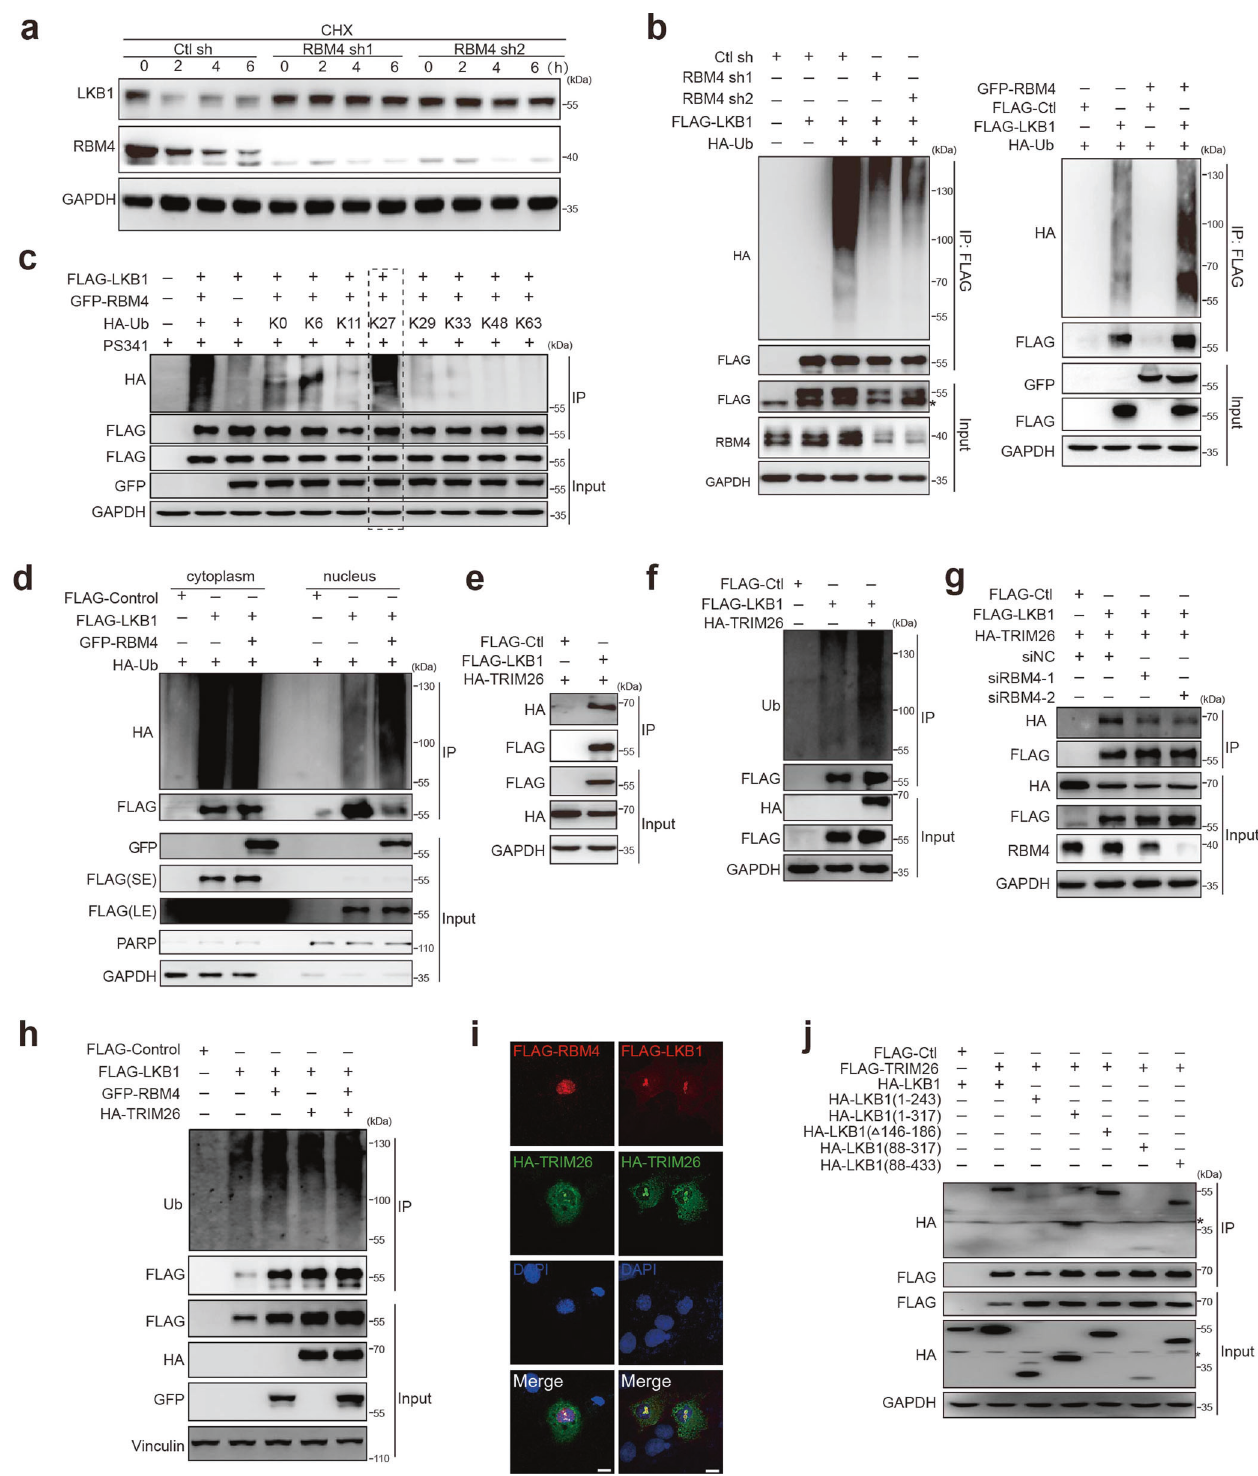
spectrometry-based proteomic pro fi ling of ESCC tumors and adjacent non-tumor tissues, 69 and found that RBM4 was increased, whereas LKB1 was decreased in ESCC samples (Supplementary Fig. 6a), further Spearman ’ s rank correlation analysis proved a signi fi cant and negative correlation between RBM4 and LKB1 (Fig. 7b). Consistently, ESCC patients with the low RBM4 expression and high LKB1 expression had signi fi cantly better Signal Transduction and Targeted Therapy (2023)